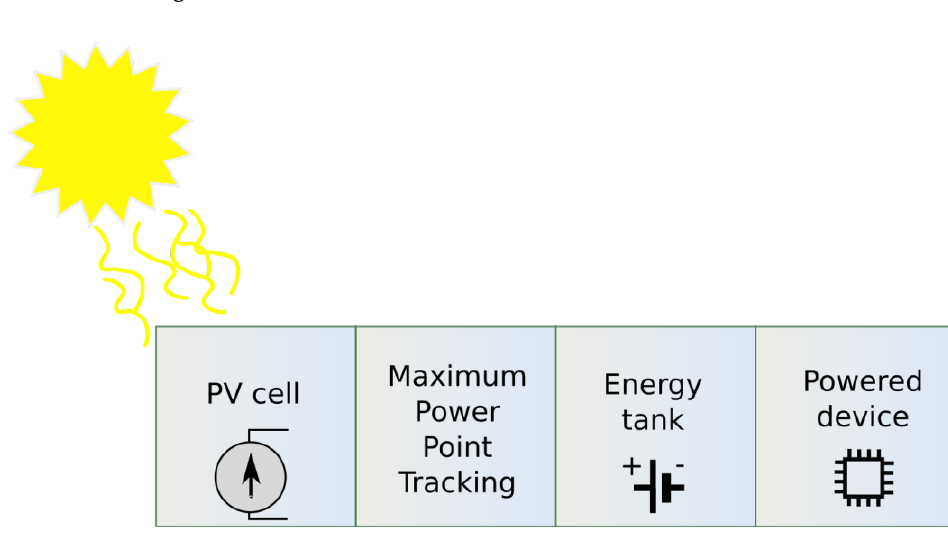
Figure 16. I-V and P-V characteristics of PV cell with MPP marked.